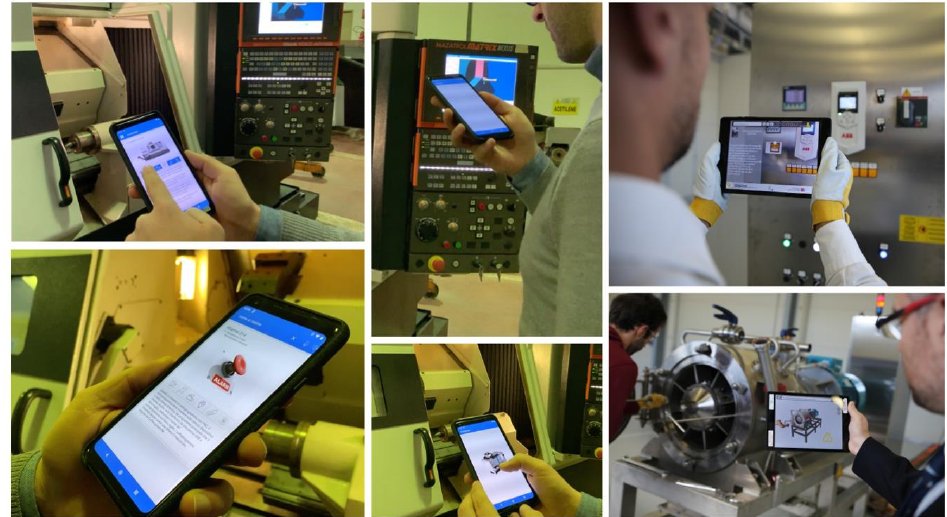
Figure 13. Prototypes of voice-enabled digital assistants that augment the worker’s interaction capabilities towards the CPPS. 653